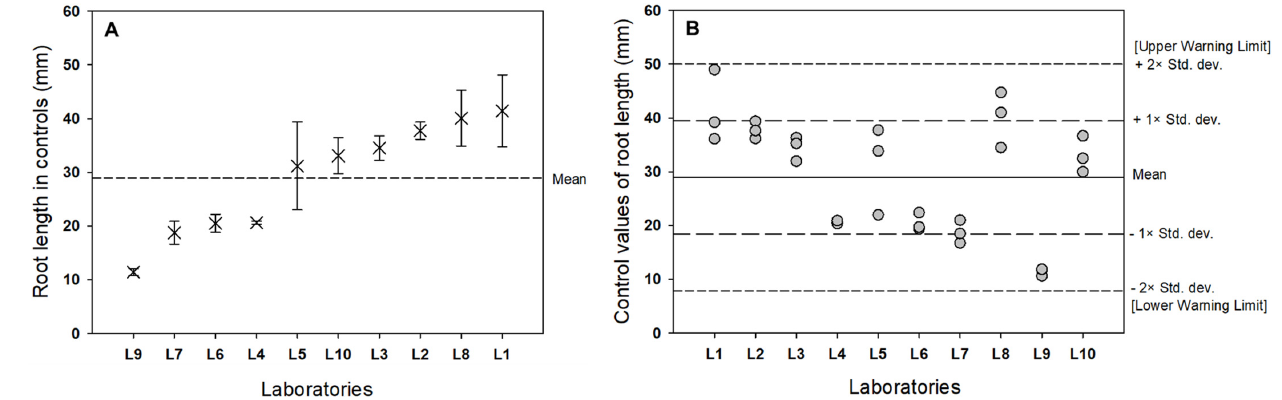
Figure 3. ( A ) Mean root length ± standard deviation of control samples from 10 laboratories. ( B ) Graphical representation of the warning chart approach to the control root lengths of Lemna minor from 10 laboratories. Table 5. Summary of interlaboratory test results based on control root length (mm) of Lemna toxicity test.